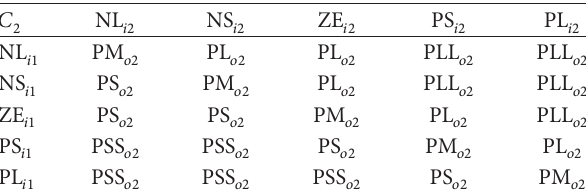
Table 5: Rule table of 𝐶 2 .